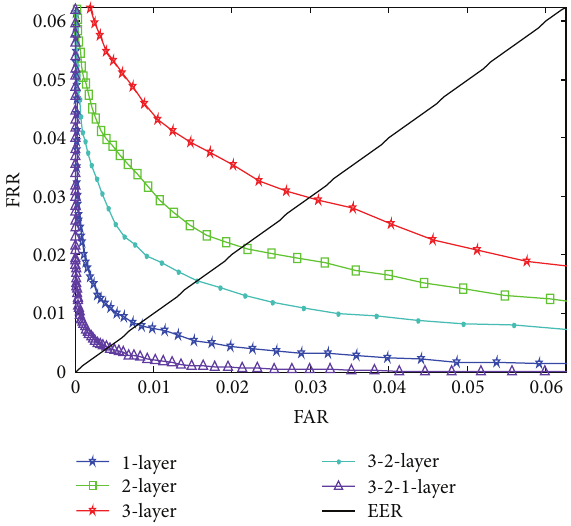
Figure 9: ROC curves of different granularity